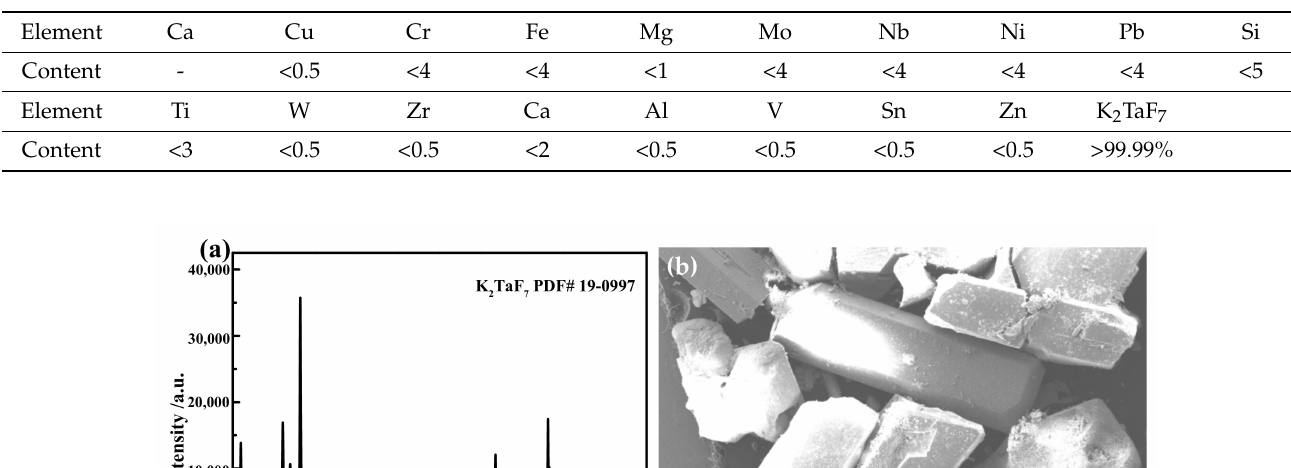
Table 5. Purity of the potassium fluorotantalate product (unit: ppm).